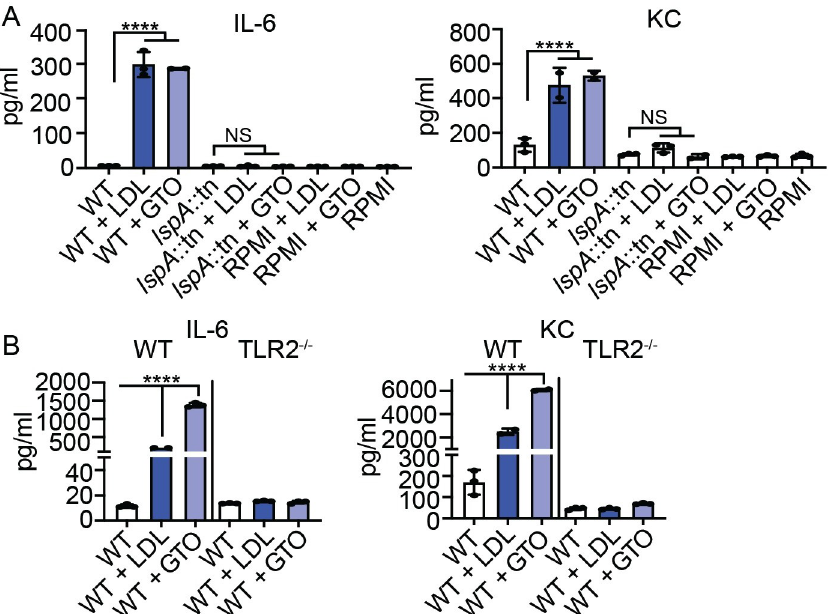
Fig 2. UFA from host lipid stores increases lipoprotein TLR2 signaling. (A) IL-6 and KC (pg/mL) production by BMMs after addition of cell-free supernatant from WT S . aureus or an lspA :: tn mutant grown in RPMI medium,